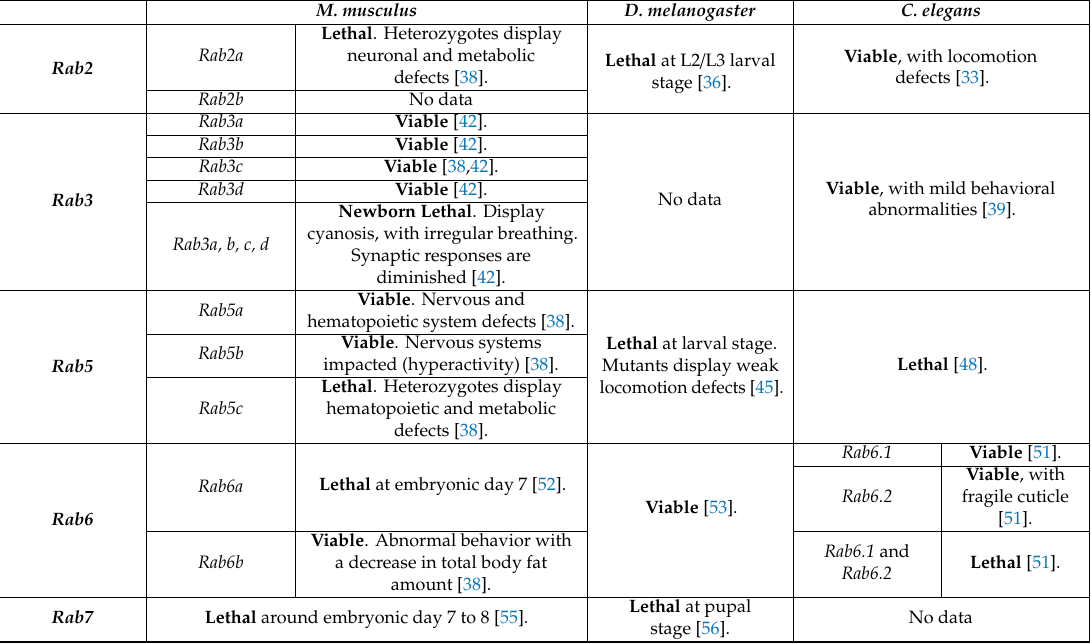
Table 1. Rab mutant-associated phenotypes in various metazoan model